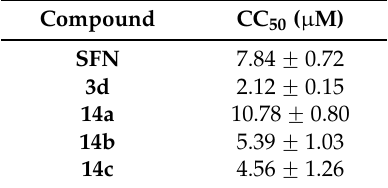
Table 3. Effect of compounds 14a – c on 293T